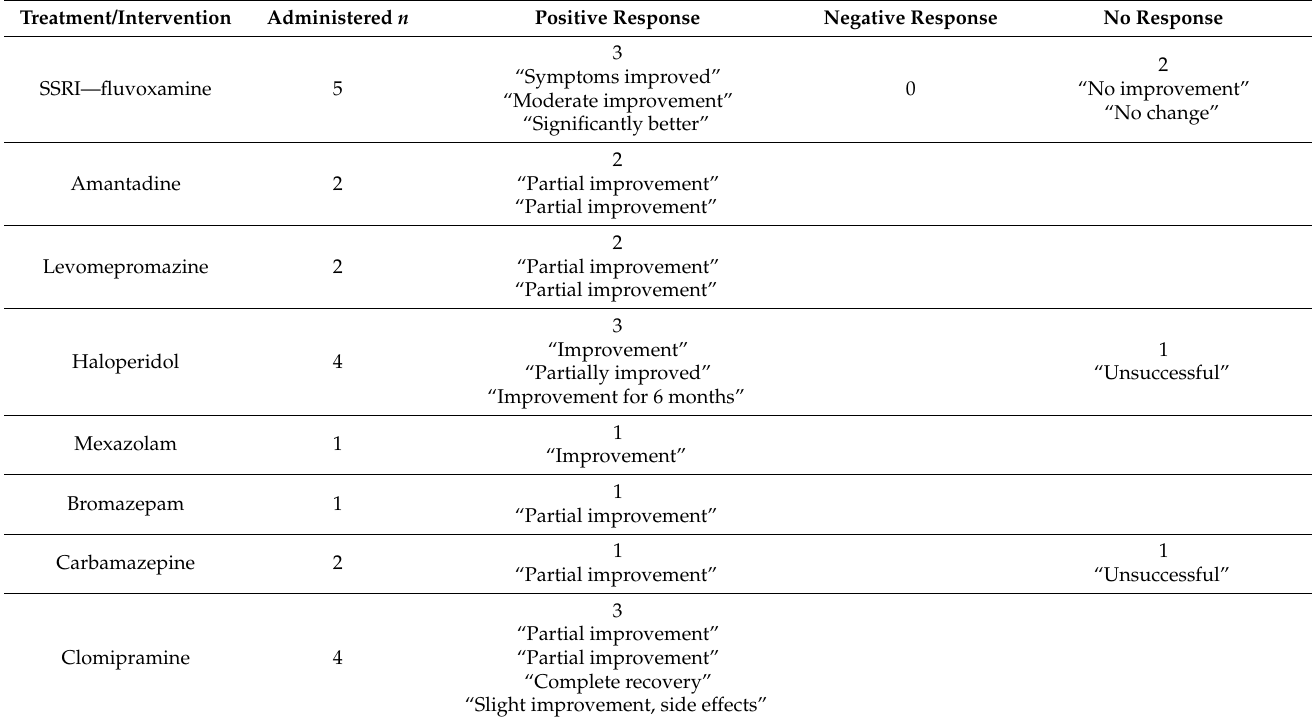
Table A1. Table showing the range of treatments administered across all papers on an individual basis alongside re- ported